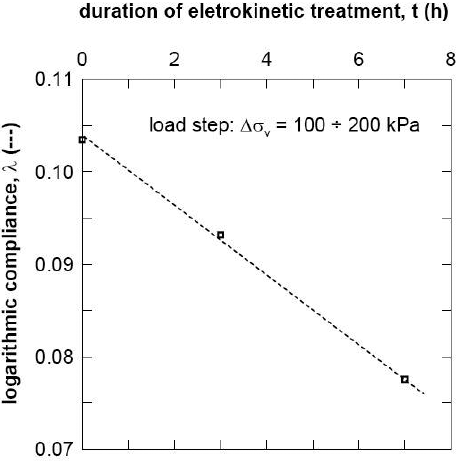
λ vs. duration of the electrokinetic treatment, at constant vertical stress. Fig. 2 – Logarithmic compliance